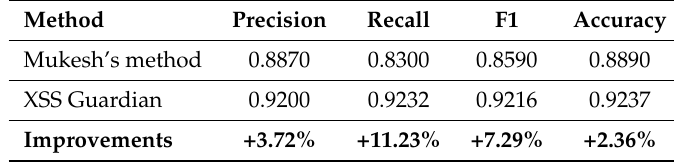
Figure 7. Accuracy and loss curve. Table 6. Performance of different